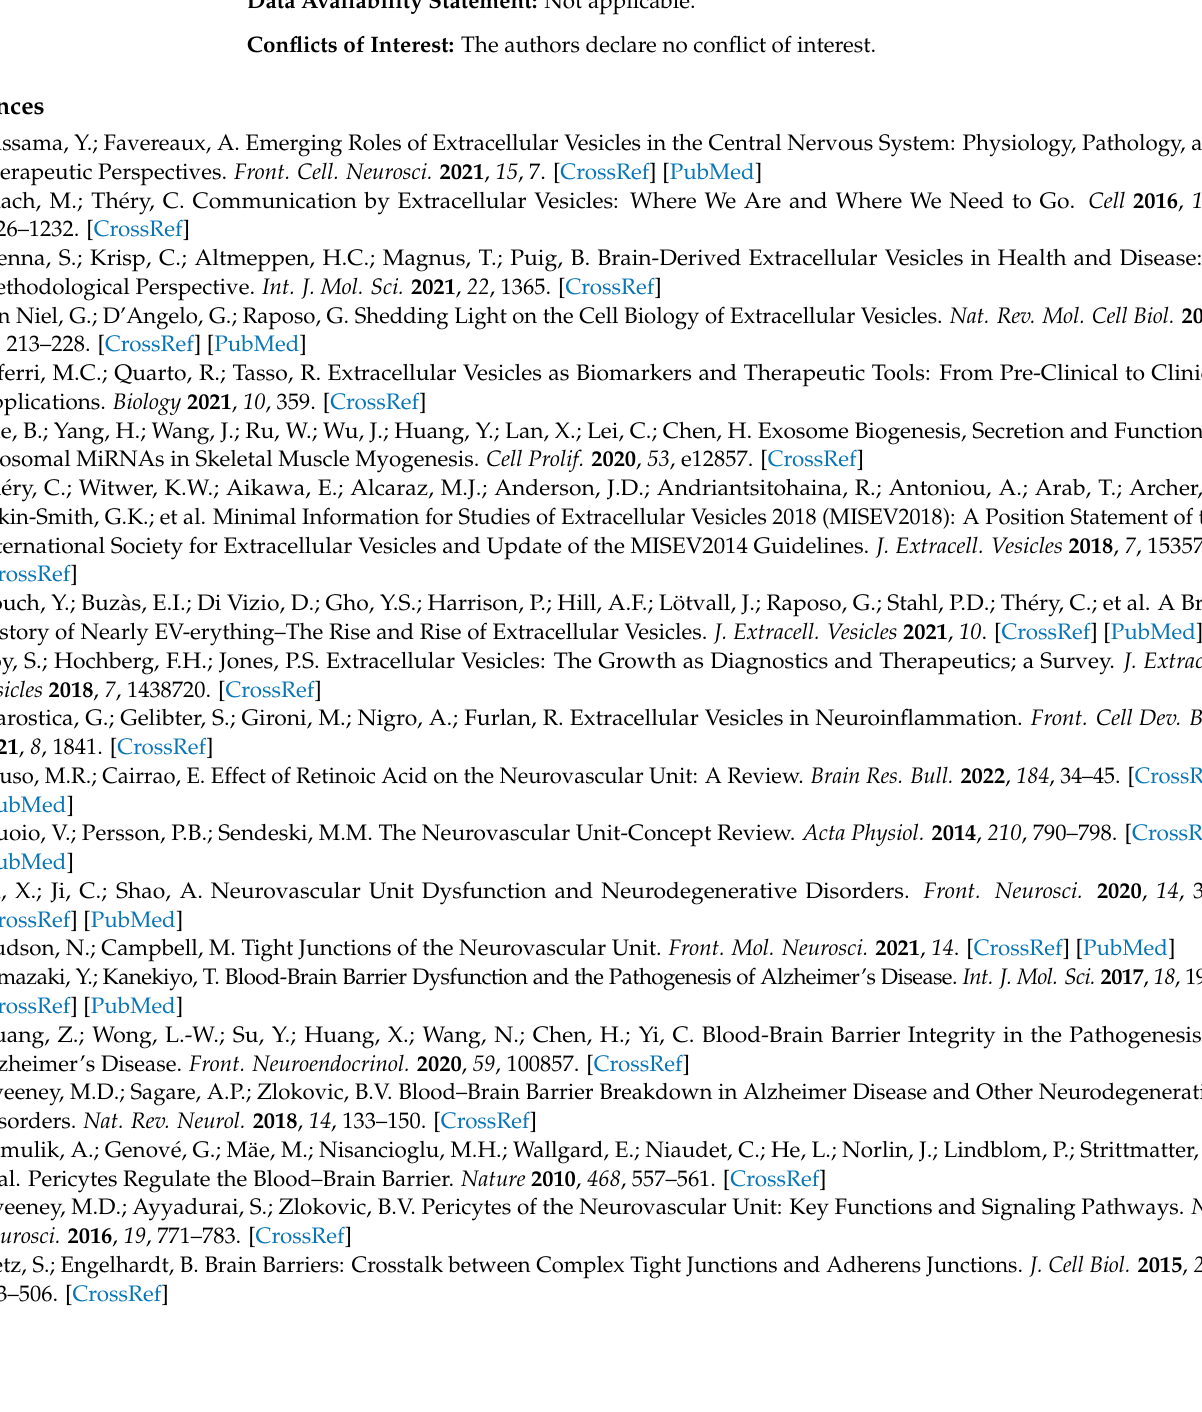
Table S3: Inclusion and exclusion criteria of studies reported in Table